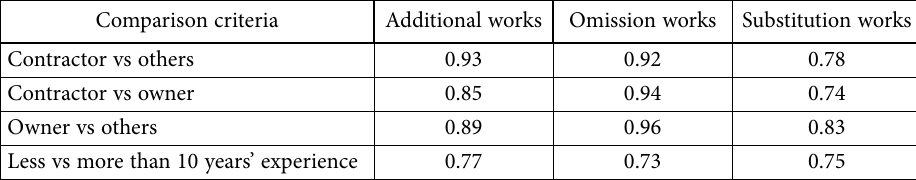
Table 4. Spearman’s rank correlation